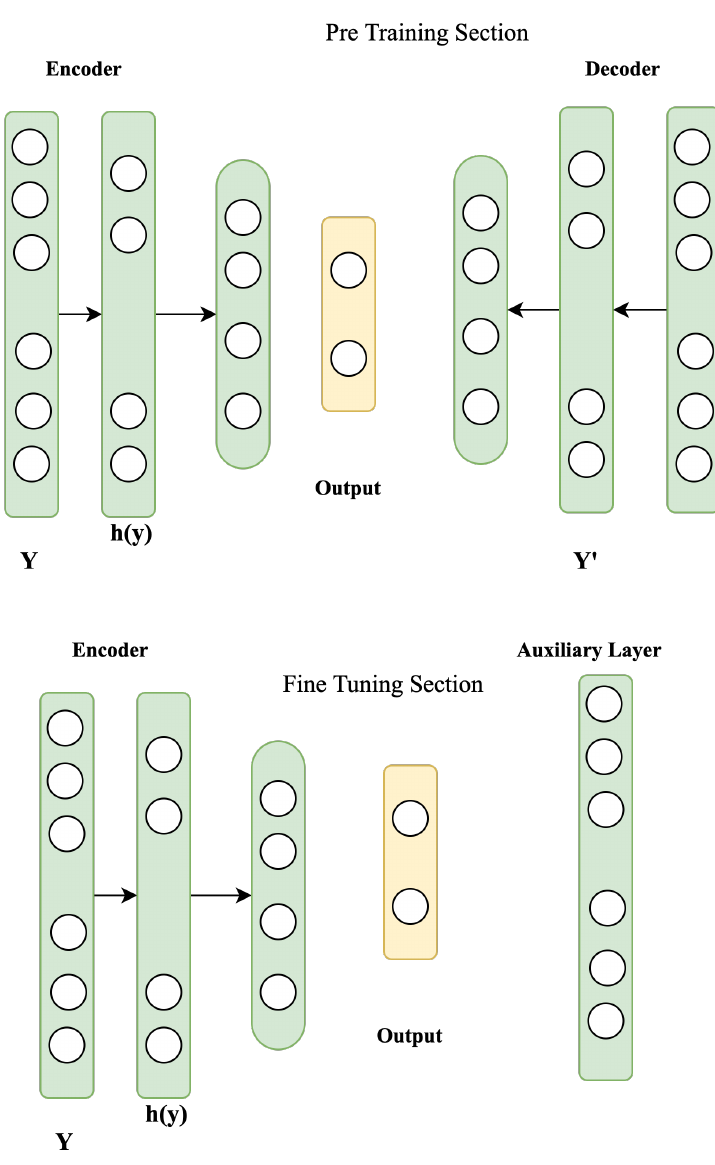
Figure 4. The Shared-Hidden-Layer Autoencoder Network